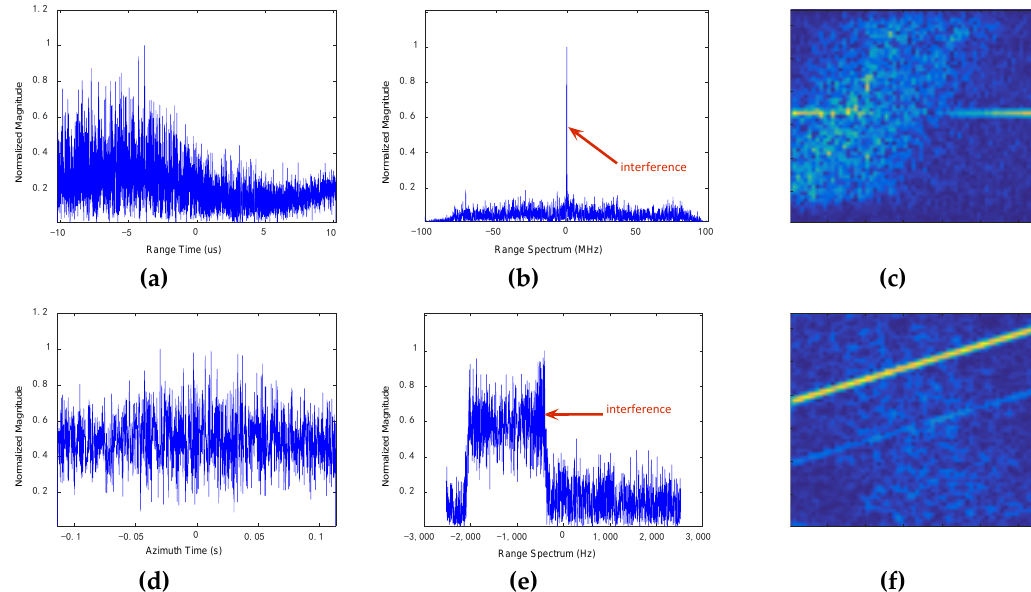
Figure 2. An example of the ( a ) NBI-corrupted echo in the range-time domain, ( b ) NBI-corrupted echo in the range-frequency domain, ( c ) NBI-corrupted echo in the time–frequency domain, ( d ) WBI-corrupted echo in the azimuth-time domain, ( e ) WBI-corrupted echo in the azimuth-frequency domain, and ( f ) WBI-corrupted echo in the time–frequency domain.